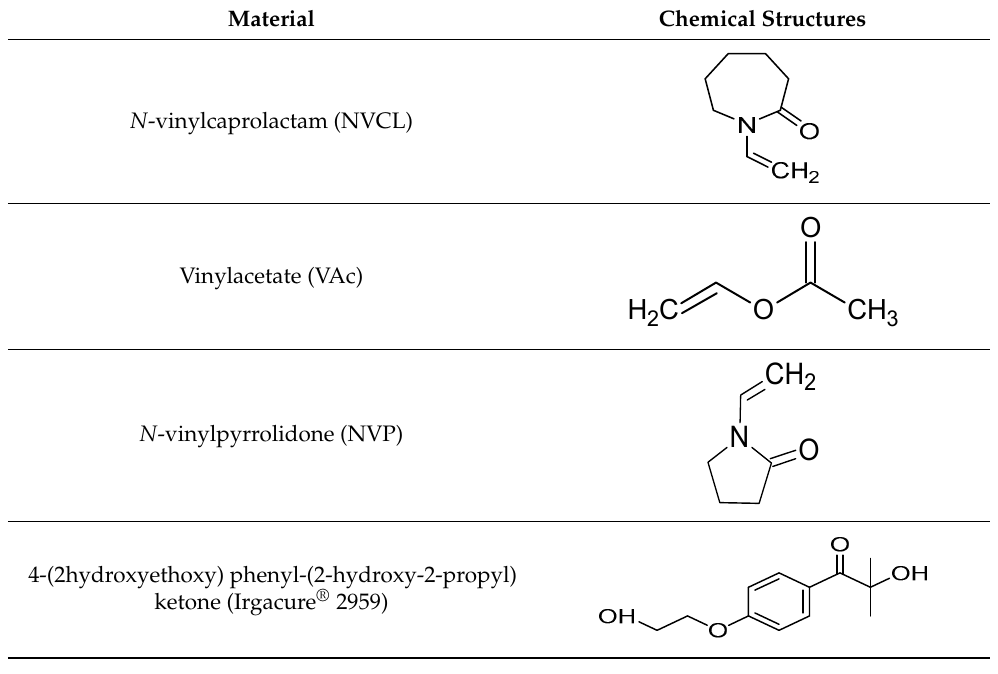
Table 1. Chemical structure of the selected materials.